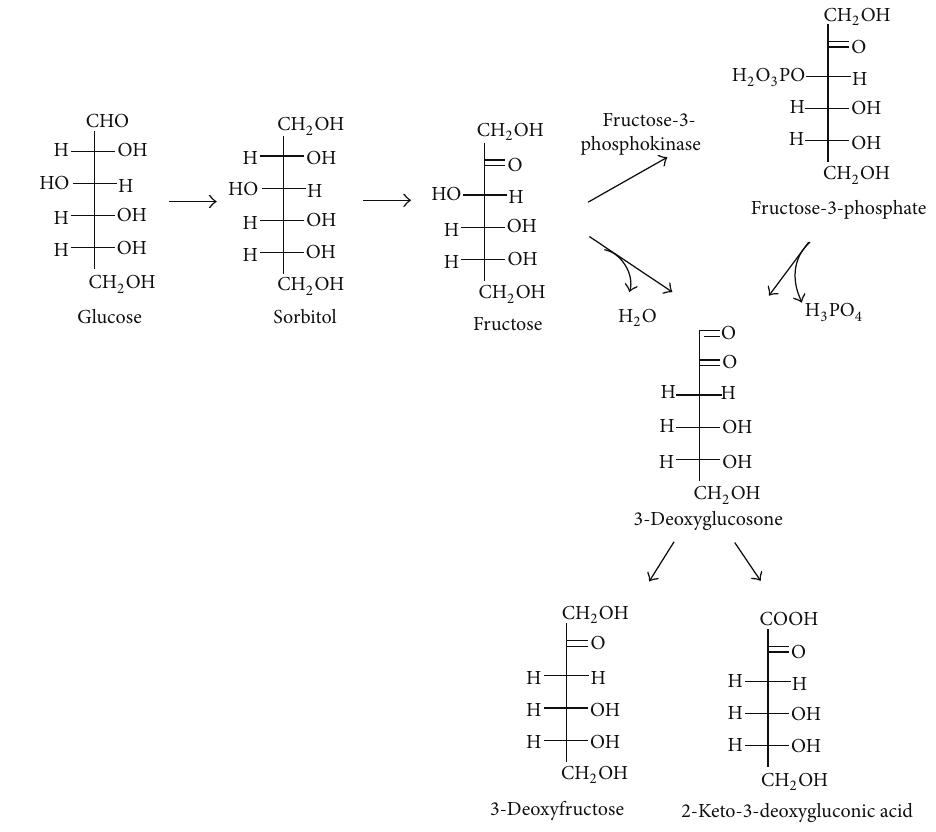
Figure 2: Formation of methylglyoxal as a by product of glycolysis.